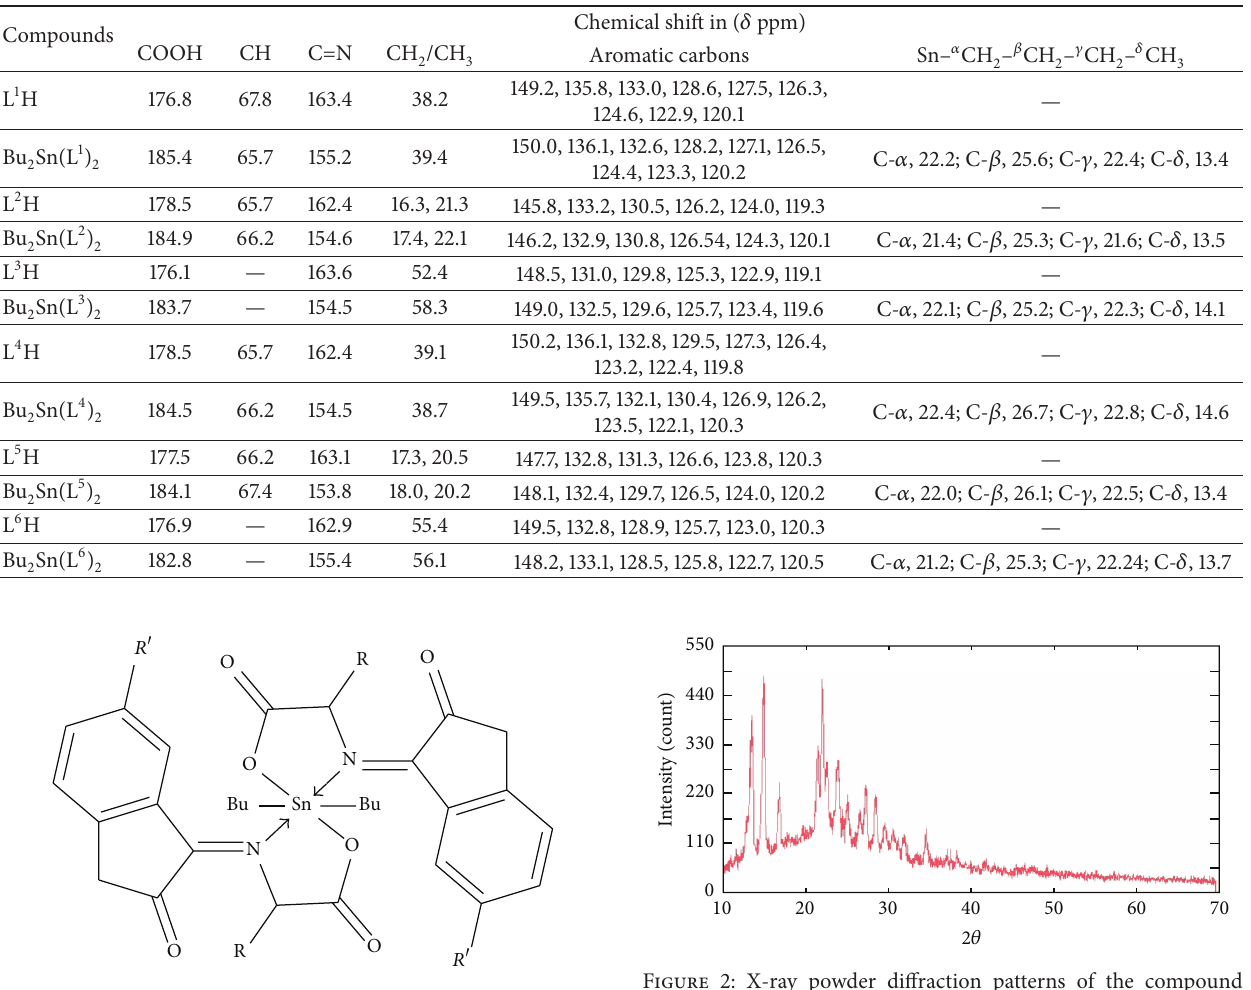
Figure 2: X-ray powder diffraction patterns of the compound [L 1 H].